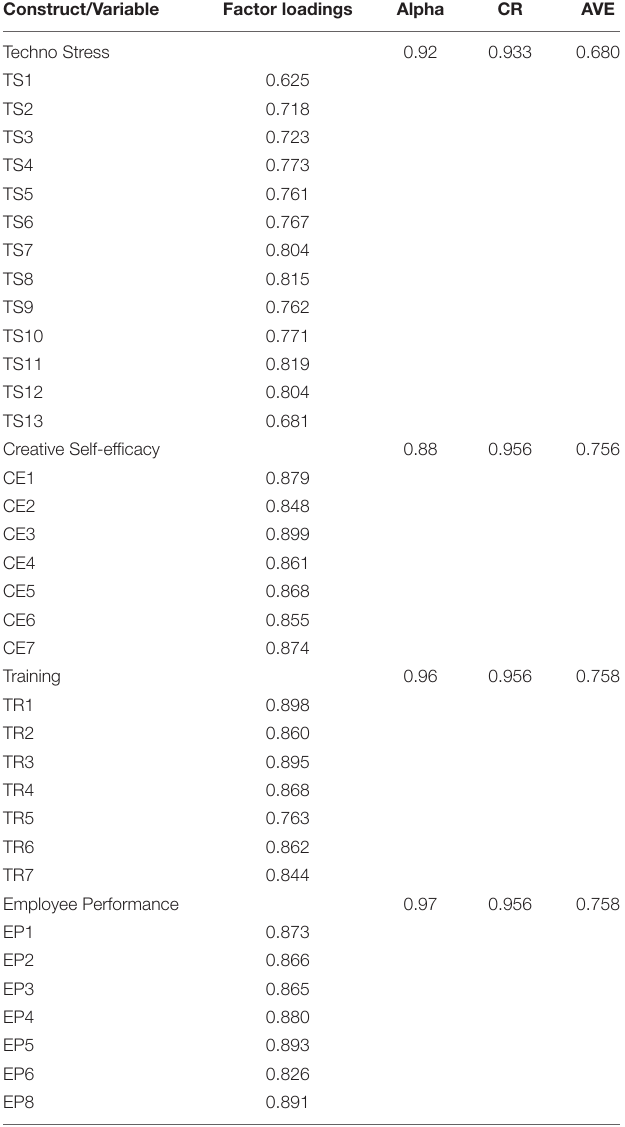
TABLE 2 | Results of confirmatory factor